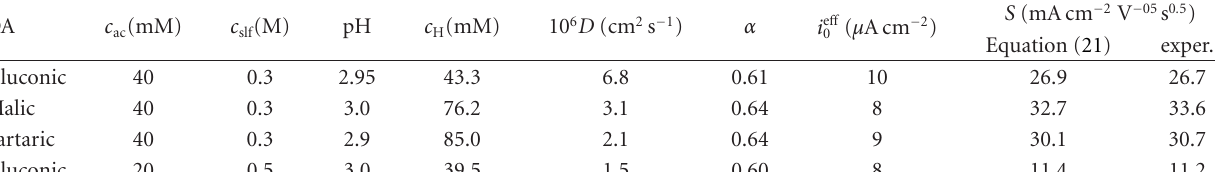
Table 3: Equilibrium characteristics of OA solutions and the kinetic parameters of hydrogen evolution.